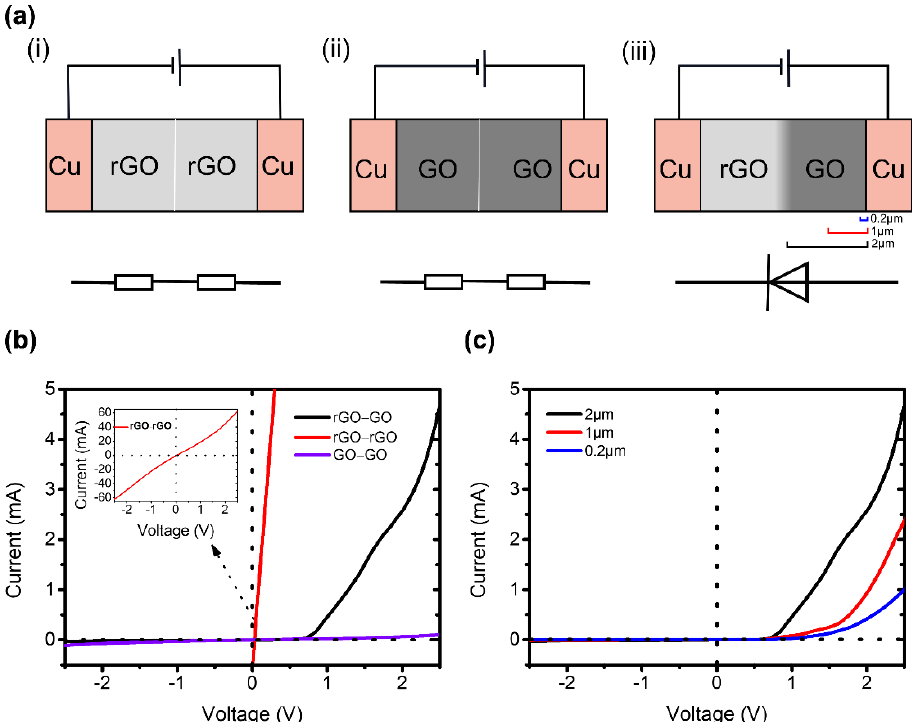
Figure 2. ( a ) Measurement schematic of rGO–rGO, GO–GO films and pGO vertical junctions. ( b ) I–V curves of rGO–rGO, GO–GO films, and pGO vertical junctions. ( c ) I–V curves of pGO vertical junctions with different thickness. Table 1. Comparison of figures in graphene p-n